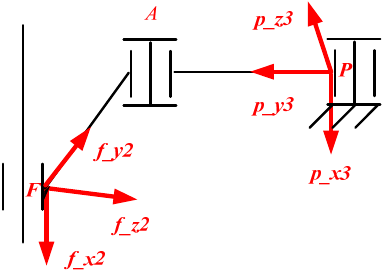
Figure 8. Coordinate system of bottom kinematic chain 1.